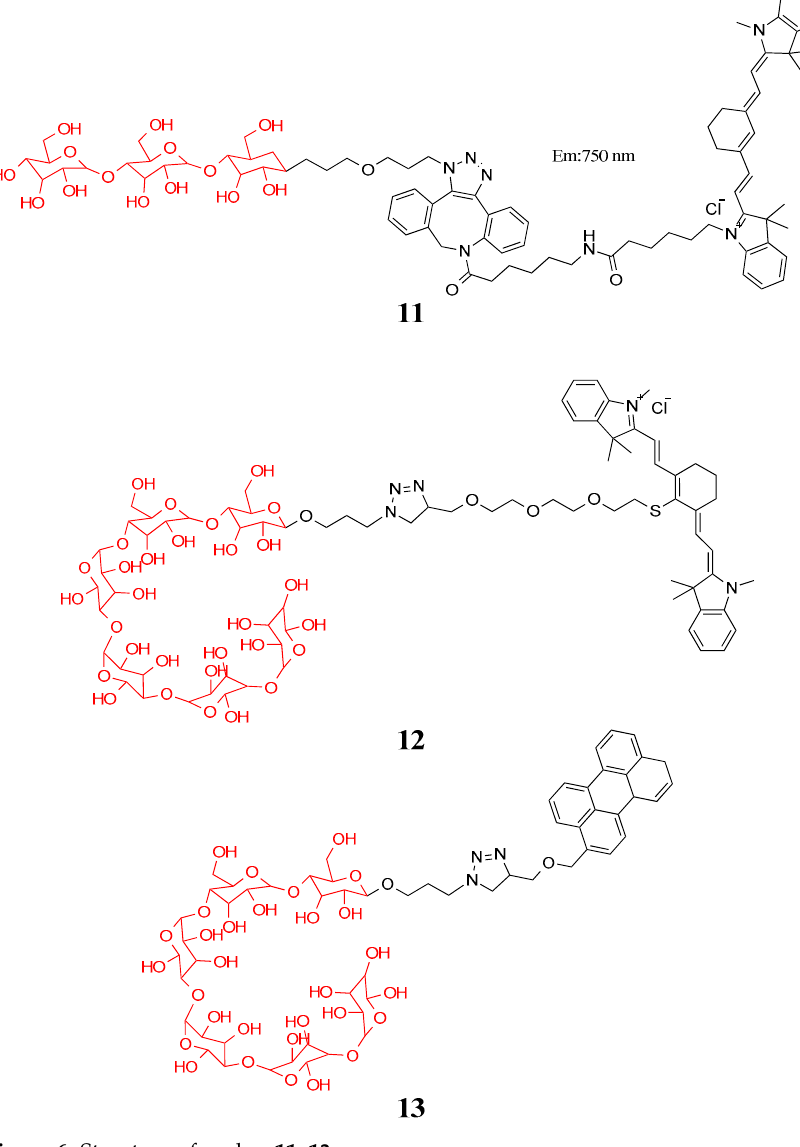
Figure 6. Structure of probes 11 – 13 .